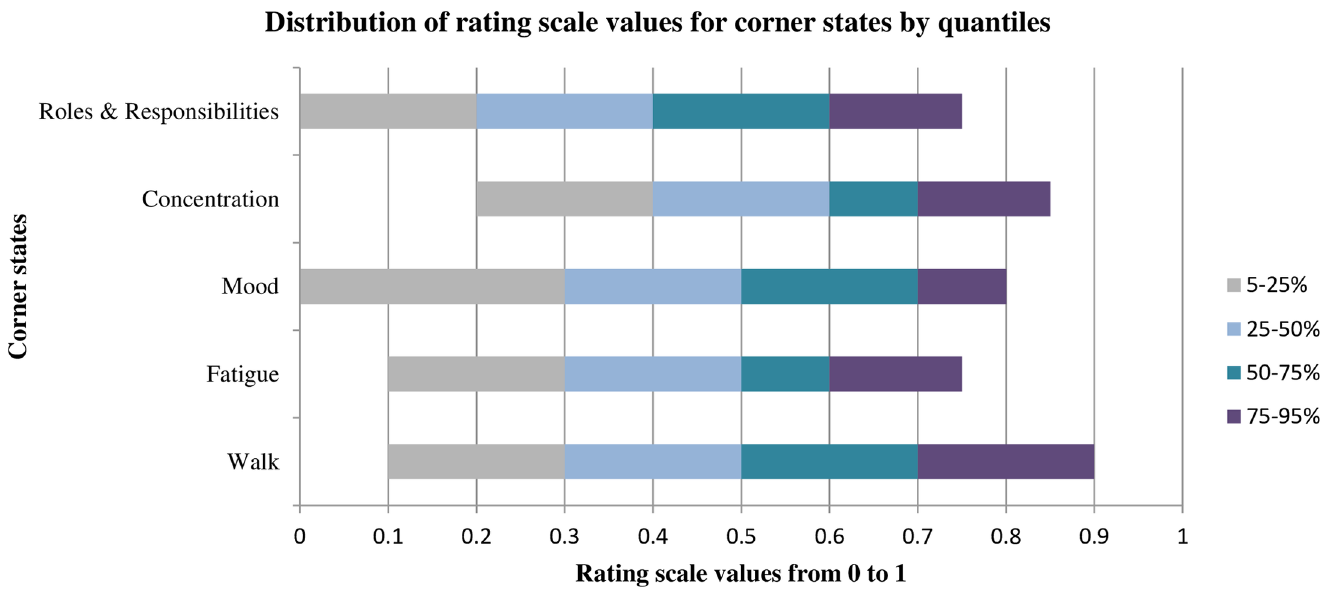
Fig 2. RS values by quantiles for PBMSI corner states in the development